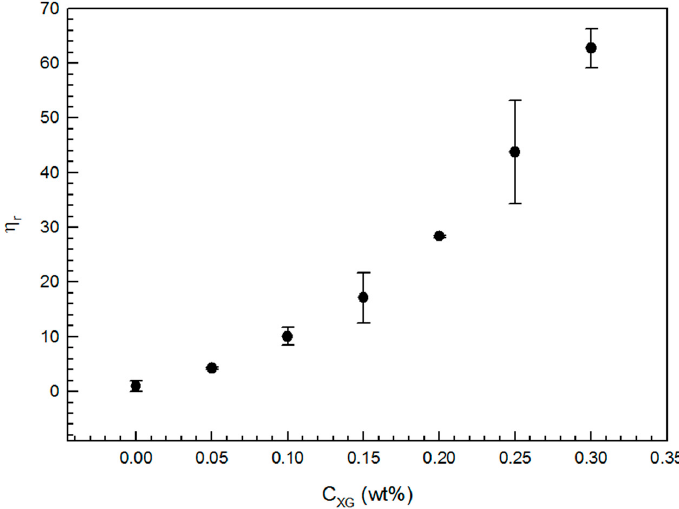
Figure 3. Variation of η r as a function of XG concentration ( C XG : 0–0.30 wt %); Cone spindle CPE-42, Shear rate: 11.54 s − 1 ; T 35 °C.